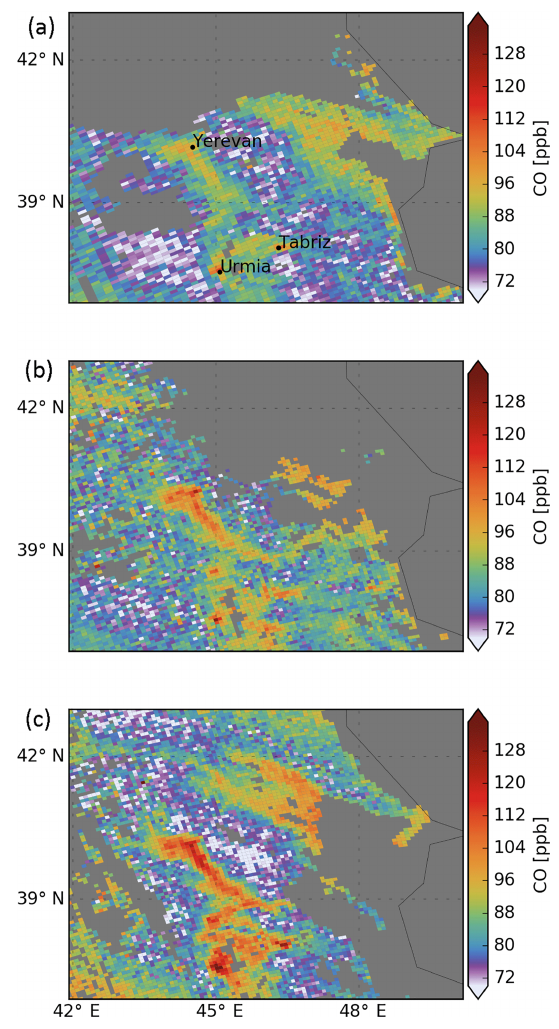
Figure 7. Sequence of high-CO pollution events measured by TROPOMI on (a) 27 November 09:31UTC, (b) 12 November 09:50UTC, and (c) 17 December 2017 09:56UTC above Armenia. The panels show the same region as in the lower part of Fig. 2.